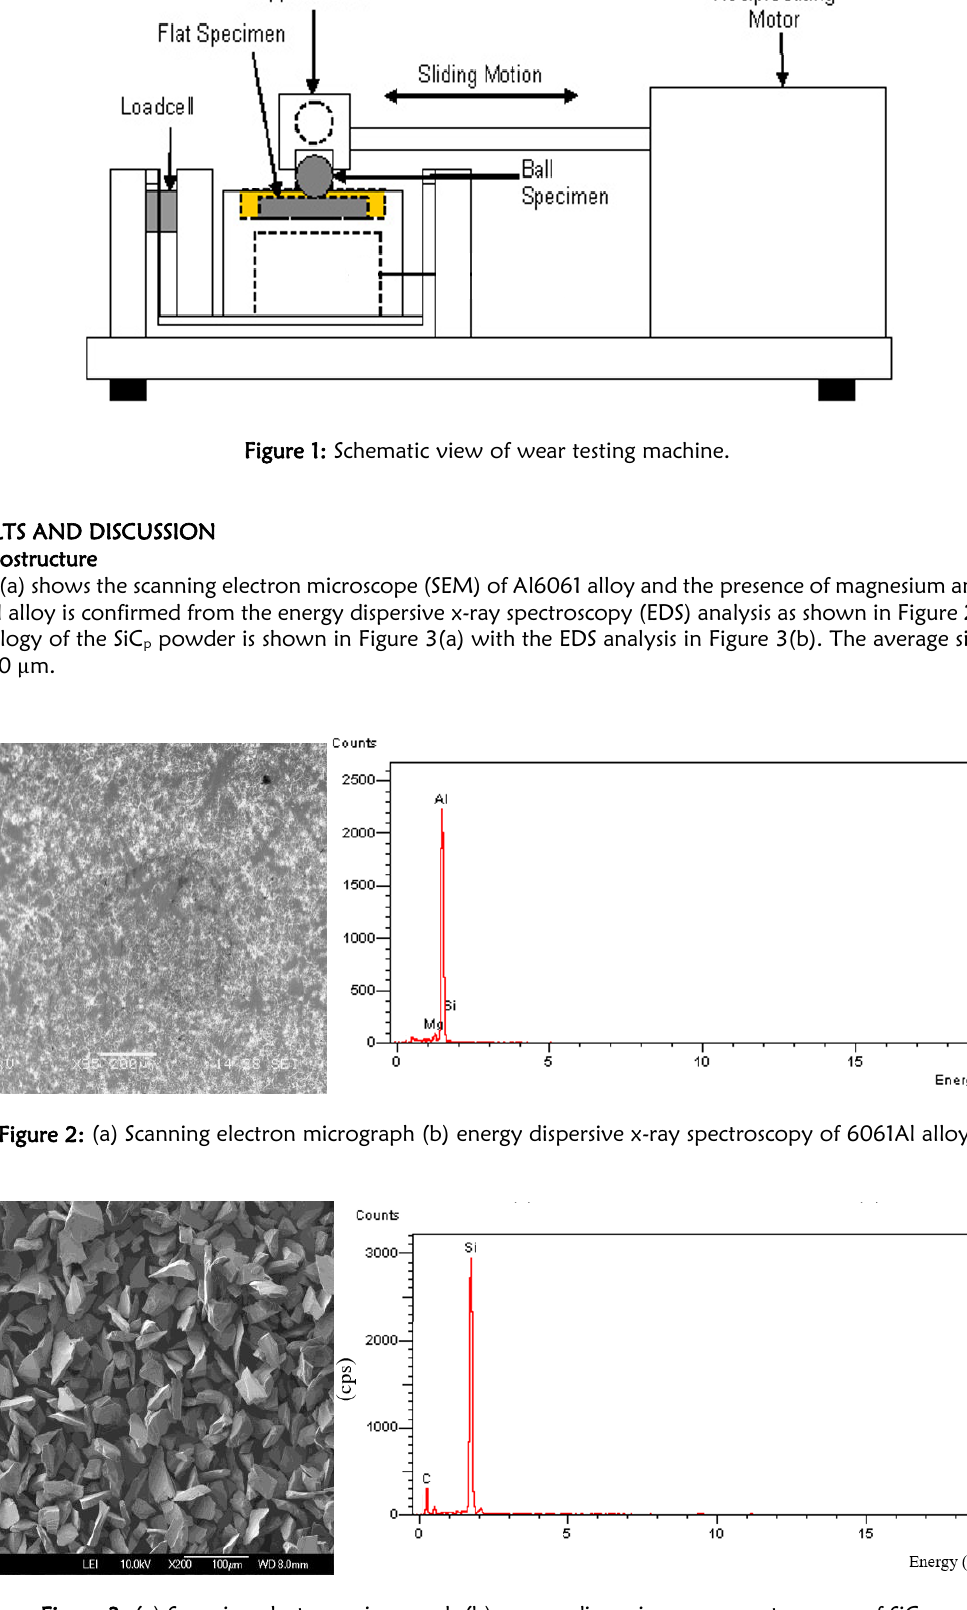
Figure 3: (a) Scanning electron micrograph (b) energy dispersive x-ray spectroscopy of SiC p